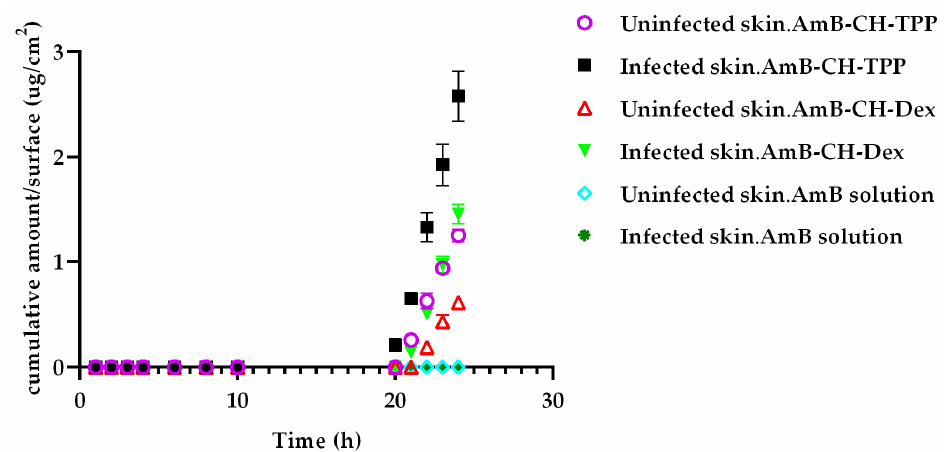
Figure 6. The cumulative amount of AmB permeated per surface area (µg/cm 2 ) through uninfected BALB/c mouse skin ( n = 5) and L. major infected BALB/c mouse skin ( n = 5). Infected skin was more permeable to both types of AmB-loaded chitosan nanoparticles than uninfected skin ( p < 0.05 by using repeated measures ANOVA). The use of AmB-CH-TPP nanoparticles enhanced AmB penetration through both healthy and infected skin compared to AmB-CH-Dex nanoparticles ( p < 0.05 by using repeated measures ANOVA). AmB-CH-TPP nanoparticles (Size = 65 ± 8 nm, Zeta potential = 25.5 ± 1 mV) or AmB-CH-Dex nanoparticles (Size = 170 ± 8 nm, Zeta potential = − 13 ± 1 mV). Table 6. Flux, lag time and the permeability coe ffi cient (kp) for AmB-loaded chitosan nanoparticles.